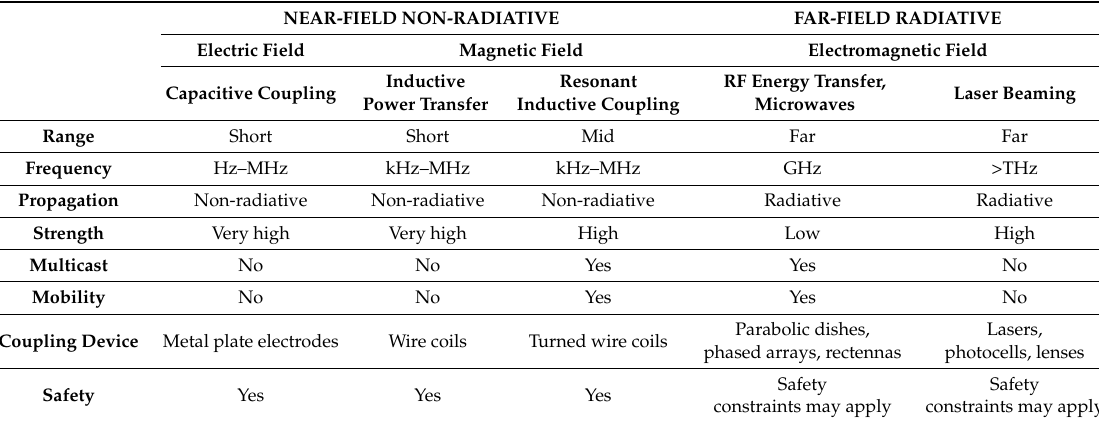
Table 1. Comparison of the main wireless power transfer (WPT)